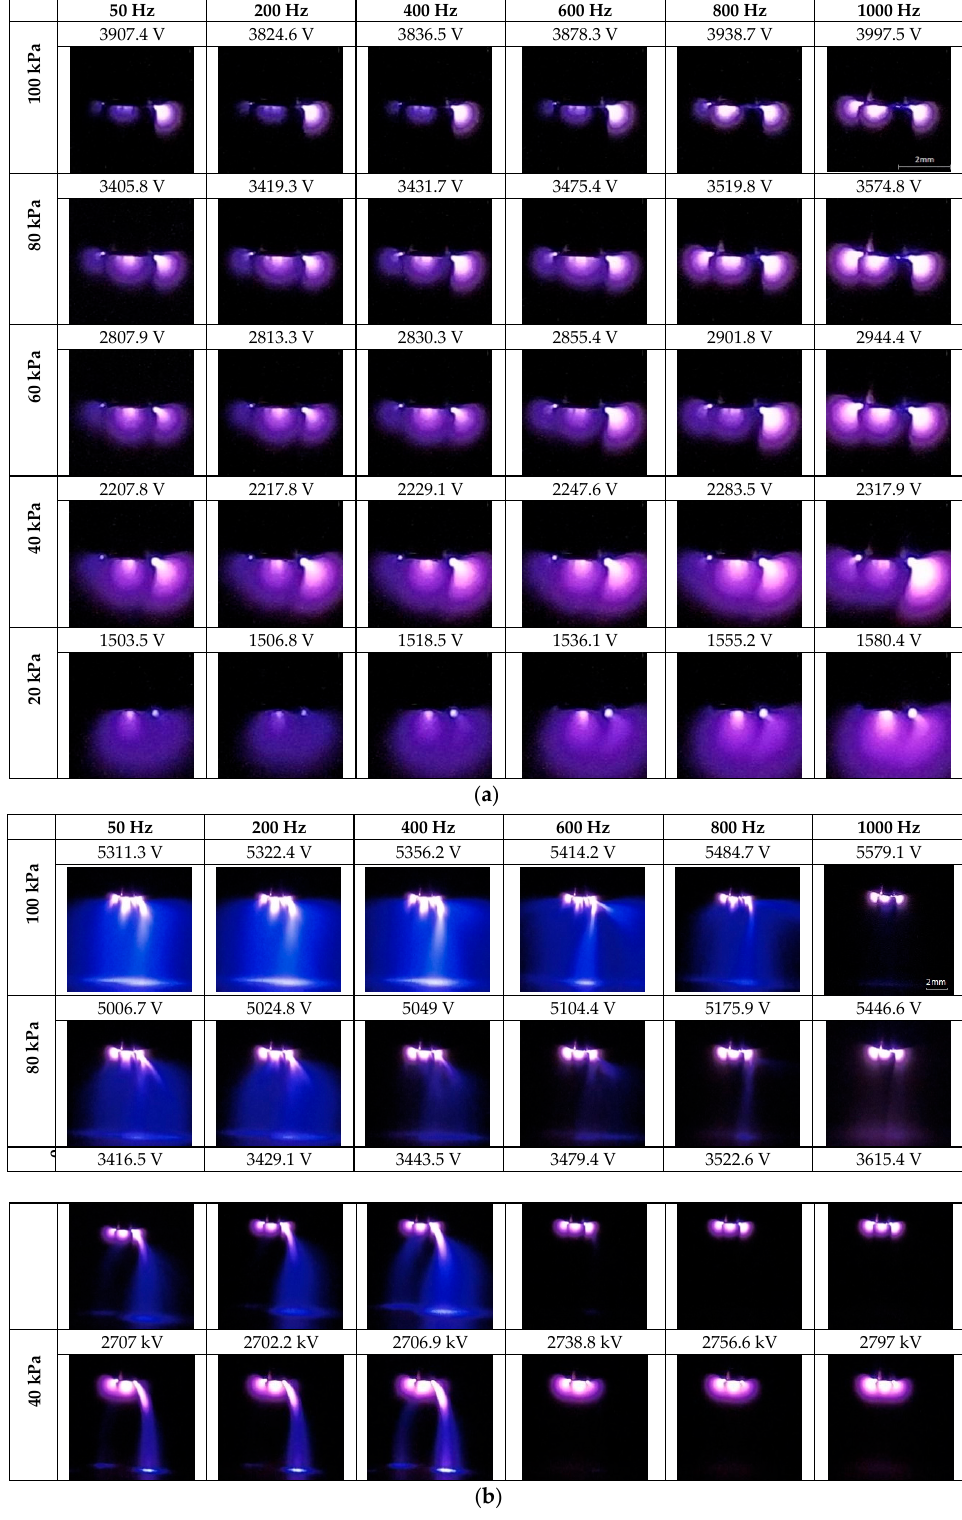
Figure 2. Long-exposure images taken with the back-illuminated CMOS sensor. ( a ) Negative ac corona discharges. ( b ) Positive ac streamer corona discharges. corona discharges. ( b ) Positive ac streamer corona